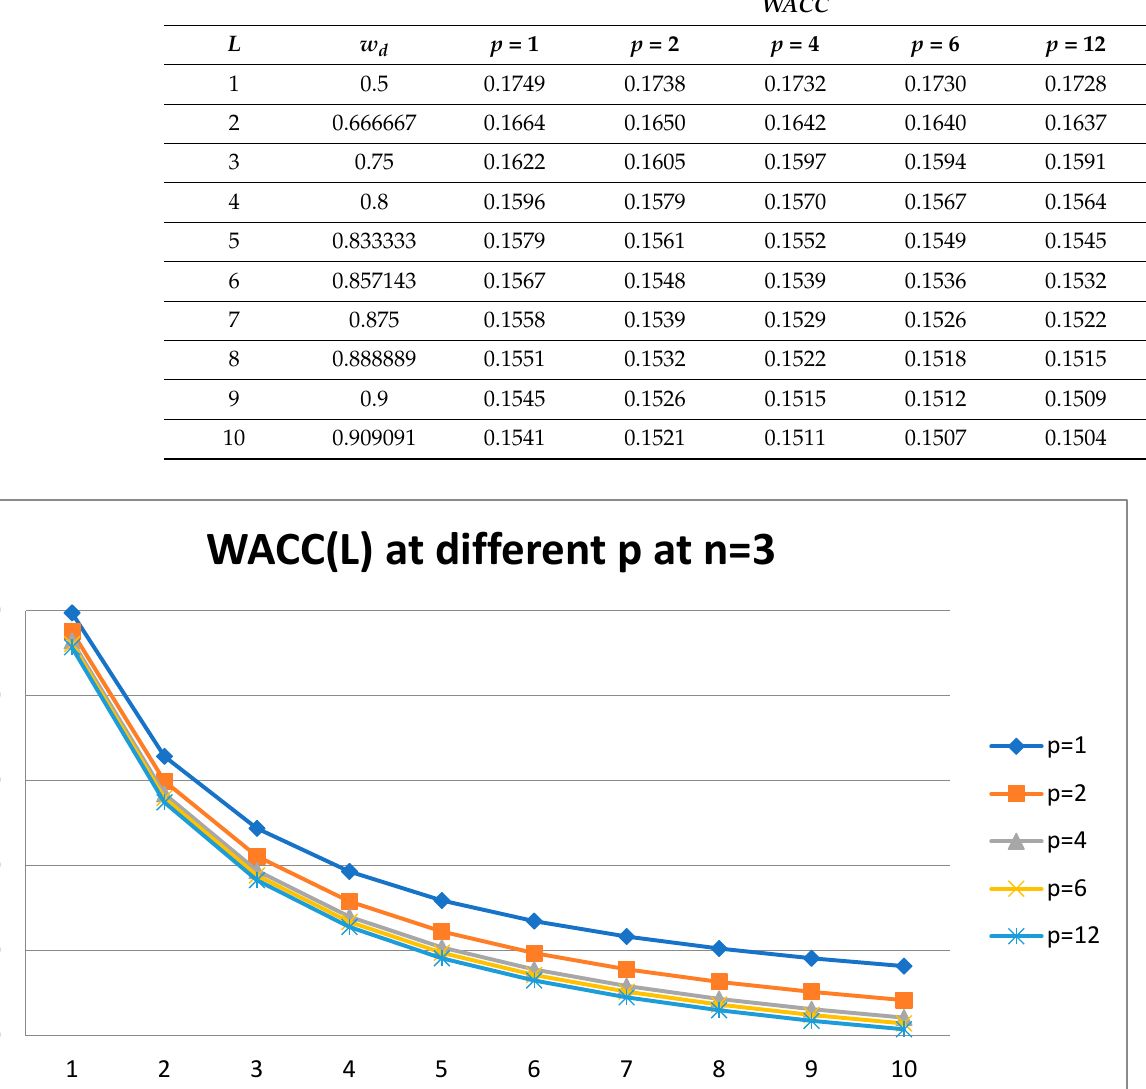
Table 3. Dependence of the company value, V , on leverage level L at different frequency of pay- ments of tax on profit p for three-year company.